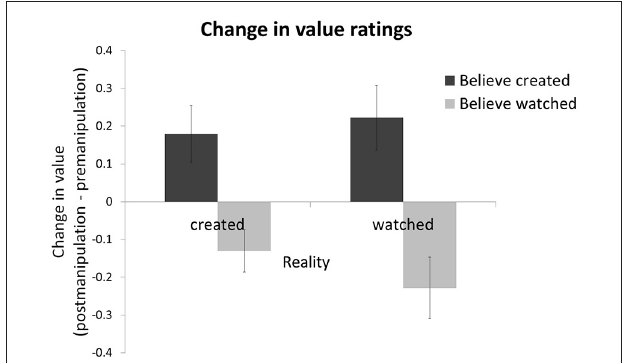
FIGURE 3 | Subjective belief, not objective reality, is related to value. Change in the value participants assigned to items (price post-manipulation minus price pre-manipulation) was greater for shoes participants believed they had created than shoes they believed they had watched being created. Whether participants in fact created or watched the shoe being created had no effect on value change. A positive score represents an increase in subjective value after the manipulation session relative to before. Error bars show within-subject standard error of the mean (Cousineau,